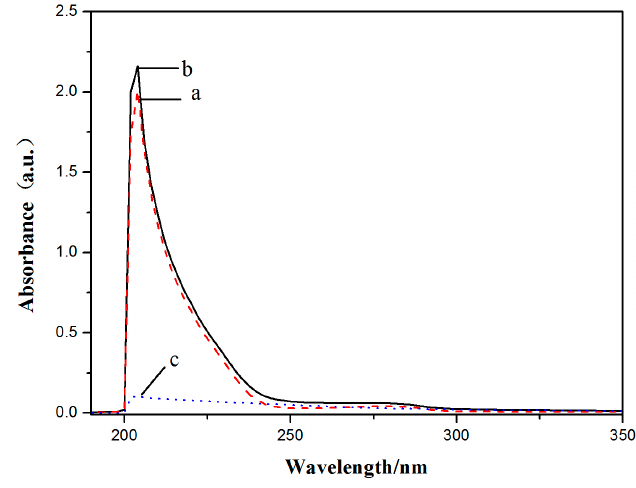
Figure 8. The effect between V 18 and human serum albumin (HSA). UV-Vis spectra of (a) 0.5 μ M HSA, (b) V 18 -HSA with molar ratio of 1:1, and (c) 0.5 μ M V 18 .